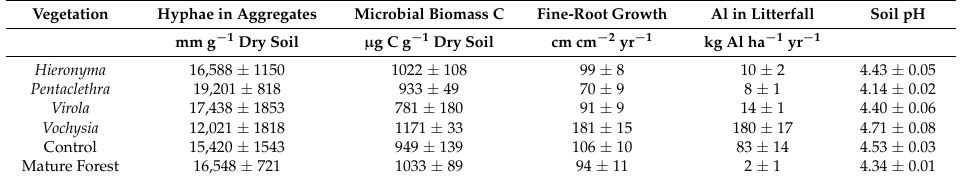
Table A2. Four biological factors and soil pH data used in evaluating relationships with macroaggregate